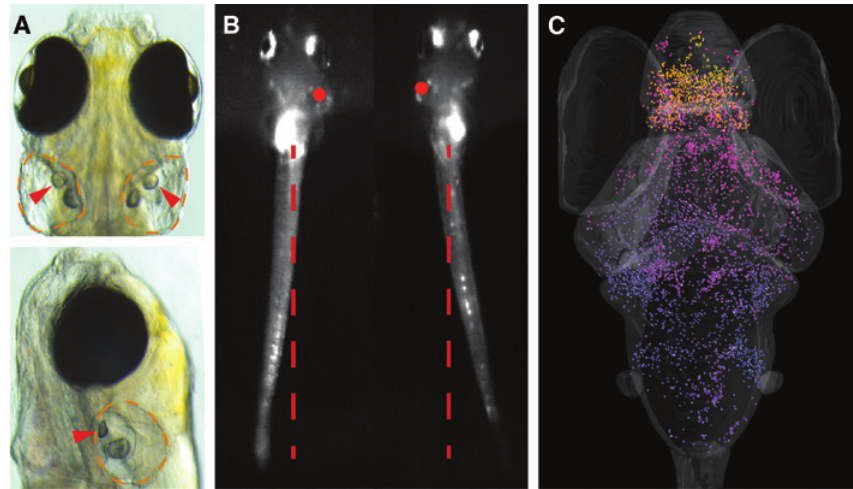
Figure 4: Manipulating zebrafish inner ear with OT. (A) Top view (top) and side view (bottom) of zebrafish. The inner ear is circled in dashed orange. Acceleration sensing otolith pointed in red. (B) Tail bend in response to single otolith exterior trapping (red dot). The original position of the tail is shown in dashed red line. (C) Distribution of neuronal intensity profiles in the brain (see details in Ref. [204]). Credit to Gilles Vanwalleghem and Nick